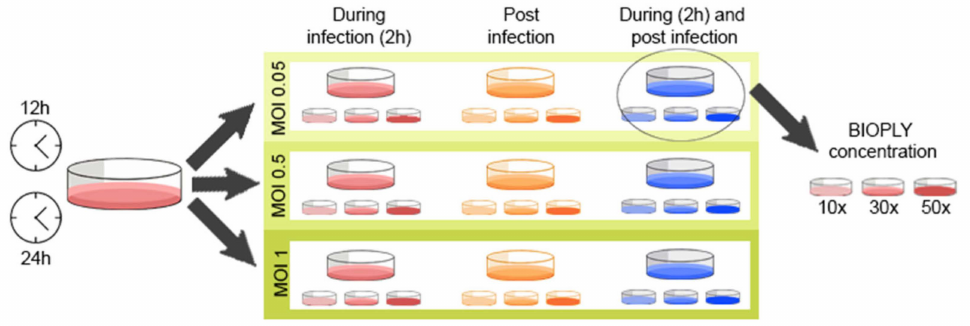
Figure 1. Standardization process for the infection settings and BIO-PLY TM treatment, considering infection time (12 h or 24 h), MOI (1, 0.5 or 0.05), BIO-PLY TM treatment (during, post or during and post infection) and BIO-PLY TM concentration (10 × , 30 × or 50 ×